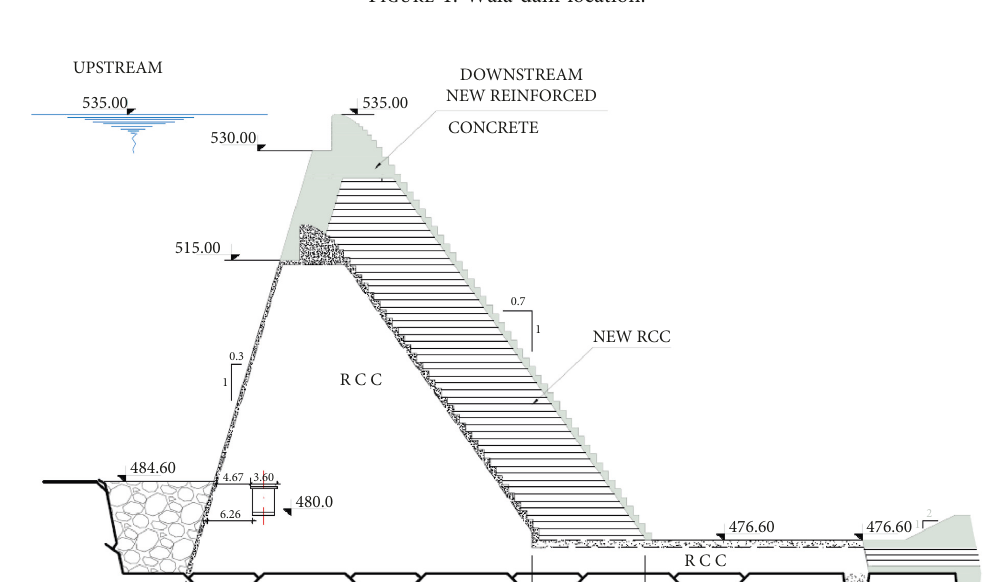
Figure 1: Wala dam location.